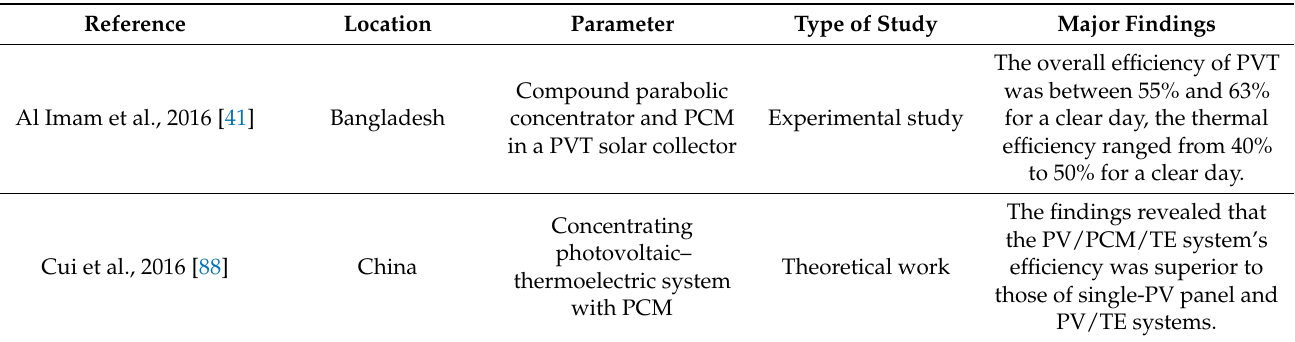
Table 3. Summary of the study-suggested models for concentrating photovoltaic thermoelectric sys- tem cooling using PCMs.